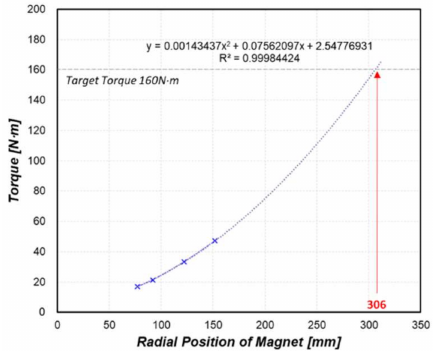
Figure 9. Torque vs. radial position of magnets